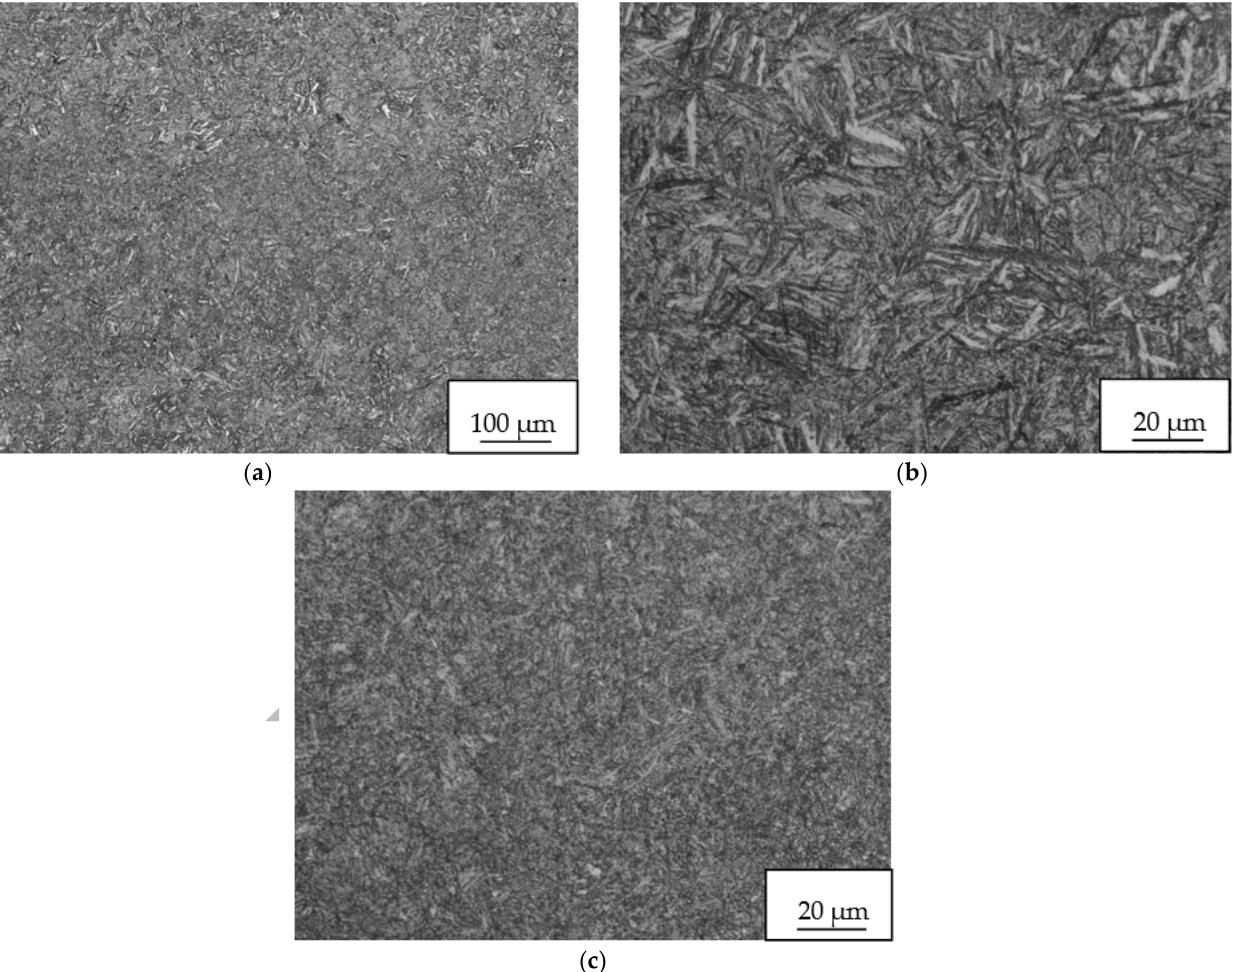
Figure 12. Microstructure in centre of steel plate consisted of tempered martensite (sample 1). ( a ) Tempered martensitic microstructure of the steel outside segregation; ( b ) Detail of the tempered martensitic microstructure of the steel outside segregation; ( c ) Detail of tempered martensite in segregation band.